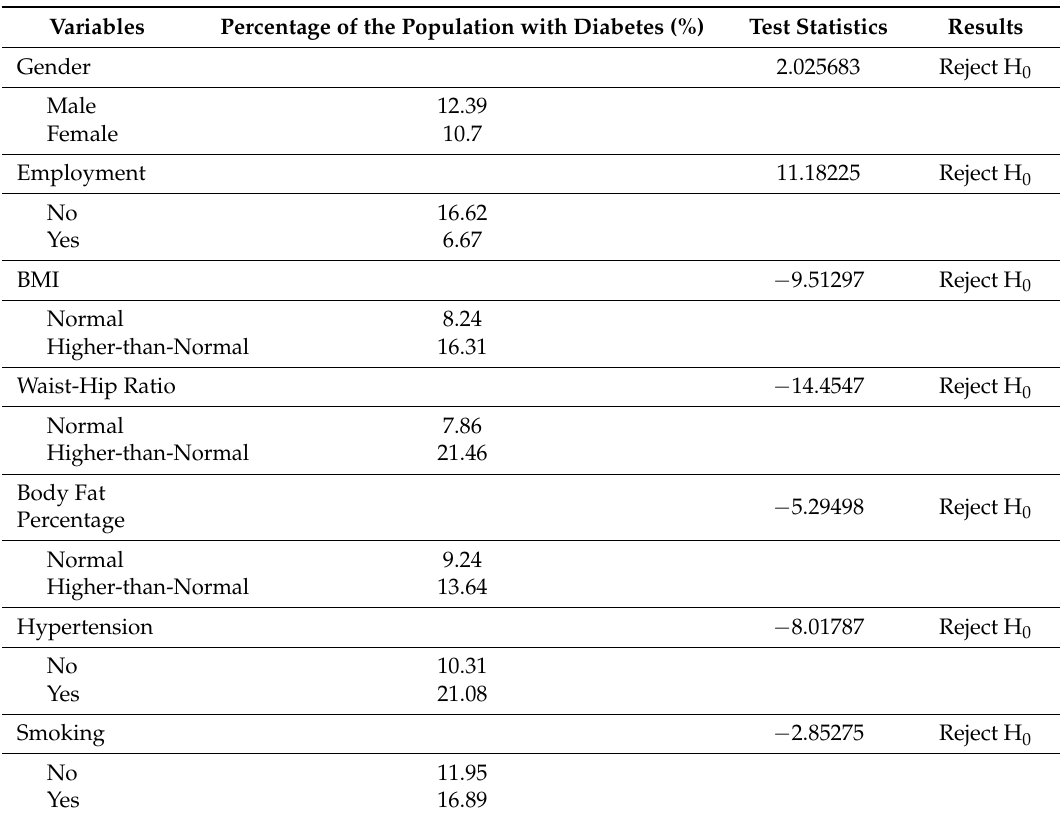
Table 2. Proportional Testing of Having Diabetes of Each